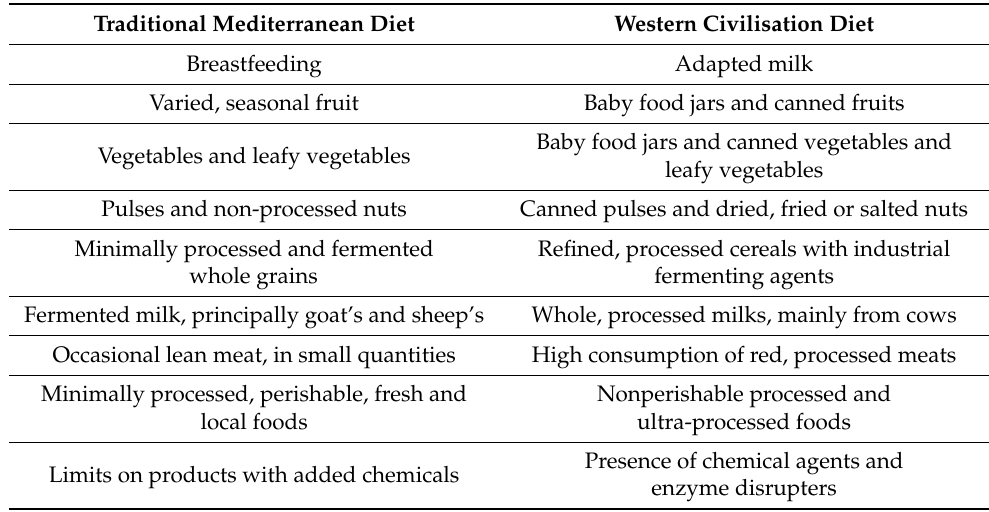
Table 3. Differences between the Traditional Mediterranean Diet and the “Western civilisation”